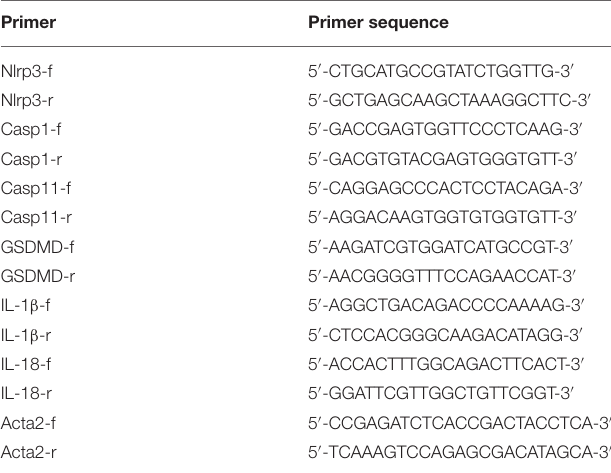
TABLE 1 | Gene-specific quantitative-polymerase chain reaction